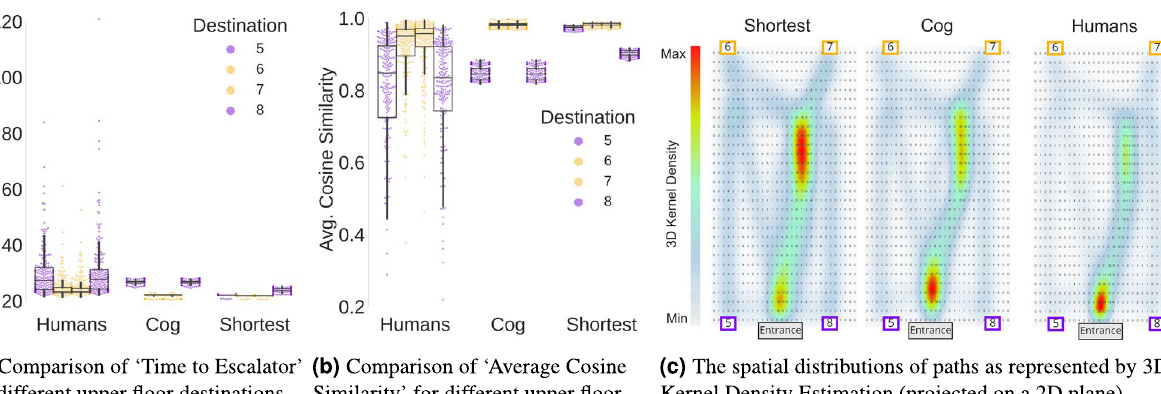
Figure 5. A comparison of wayfinding behavioral characteristics and path distributions across agent types and compared to observed human behavior. Software used to create these figures: Python 34 (version 3.5.8), https:// www. python. org/ downl oads/ relea se/ python- 358/; Seaborn 35 (version 0.11.1), https:// seabo rn. pydata. org/ index. html; Matplotlib 36 (version 3.3.2), https:// matpl otlib. org/3. 3.2/ users/ insta lling. html; QGis 38 (version 3.16), https:// qgis. org/ en/ site/ forus ers/ downl oad. html. Coef. Std.